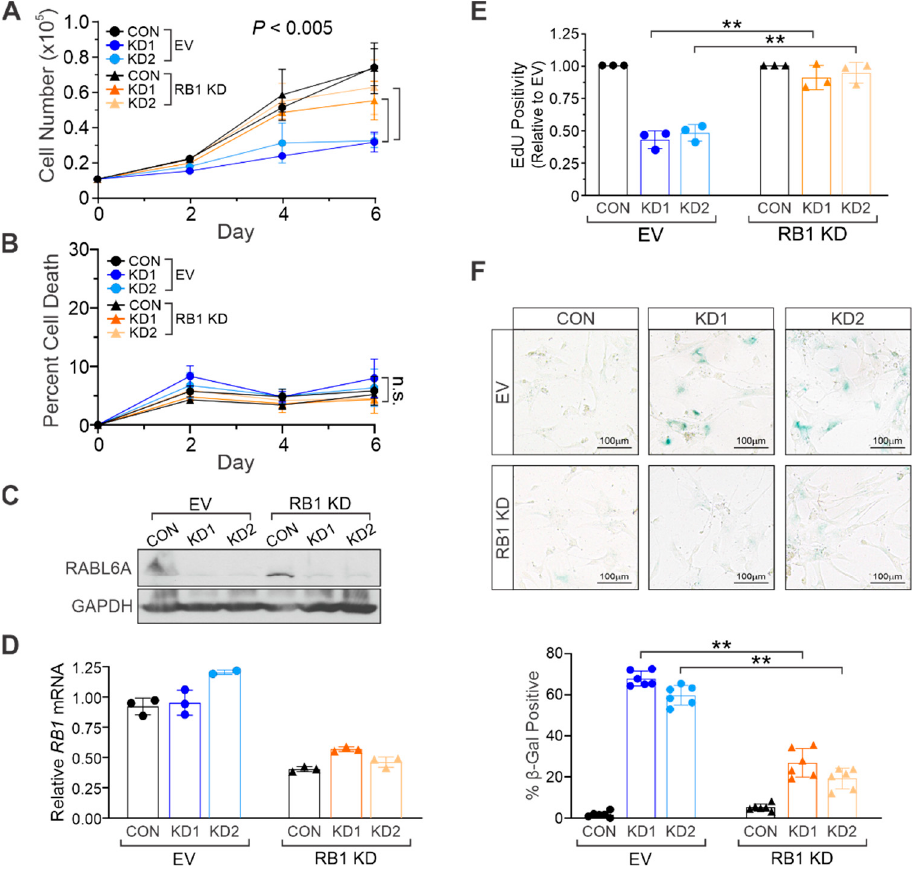
Figure 3. RABL6A promotes NHSC proliferation via RB1 inactivation. Control (CON) and RABL6A knockdown (KD1 and KD2) in low passage empty vector (EV) and RB1 knockdown (RB1 KD) cells were plated at equal density, and ( A ) cell number or ( B ) percent of cell death in the population (as measured by trypan blue exclusion) was counted days 2, 4, and 6 after plating. ( C ) Representative Western blot shows efficient knockdown of RABL6A in KD1 and KD2 samples relative to CON. ( D ) Relative mRNA levels of RB1, demonstrating knockdown of RB1 in RB1 KD samples. ( E ) Quantification of EdU positivity showing RB1 loss restores proliferation in cells with RABL6A knockdown. ( F ) Representative bright field images of β -galactosidase staining, showing the senescence caused by RABL6A loss is attenuated with co-depletion of RB1. Below, quantification of β -galactosidase staining from three experiments performed in duplicate. ( A , B ) p value determined by a generalized linear model to assess the difference between CON KD1 vs. RB1 KD1 and CON KD2 vs. RB1 KD2 (as indicated by brackets). Error bars, SD from mean. ( E , F ) p value, Two-way ANOVA with Bonferroni correction. (**, p < 0.001).